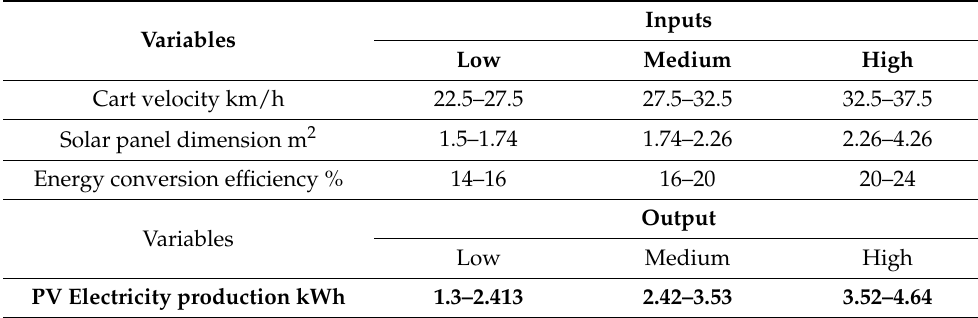
Table 5. Levels and name of outputs obtained from the fuzzy logic system and input values.